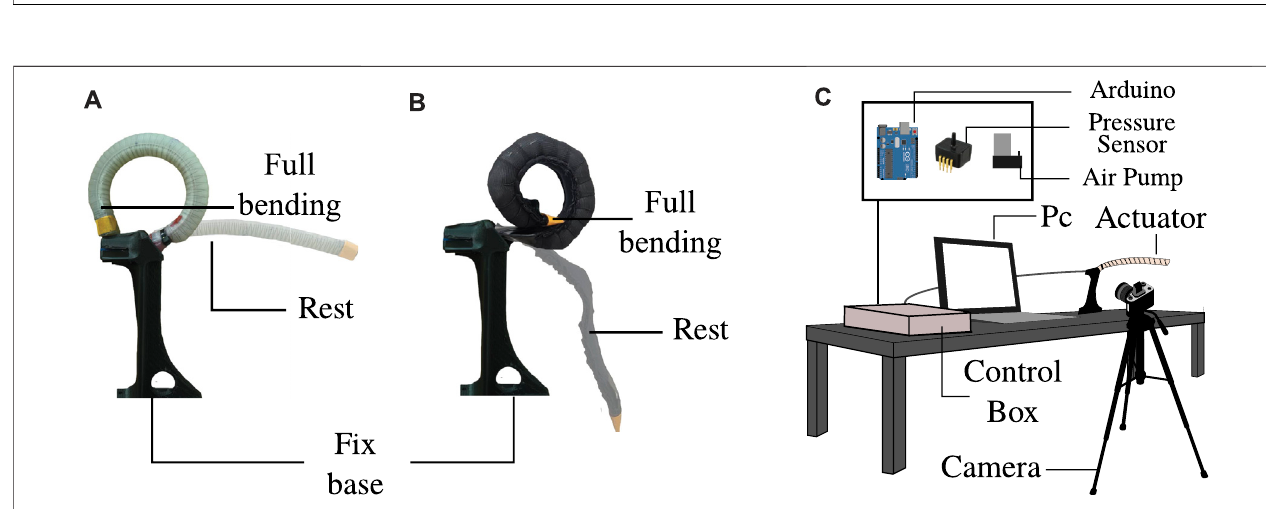
FIGURE 4 | Test measurement of the pressure required to achieve full bending. (A) De fi nition of full bending in the textile actuator and (B) the silicone actuator. (C) Setup of the key elements to perform the test measurement.